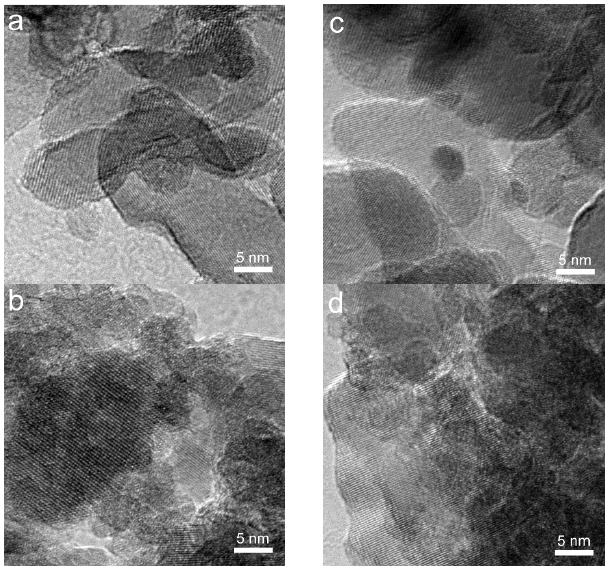
Figure 4. HRTEM images ( a – d ) of Au/FeO x catalysts: ( a ) Au/Fe_O_300, fresh; ( b ) Au/Fe_O_200, fresh; ( c ) Au/Fe_O_300, used; and ( d ) Au/Fe_O_200 used.